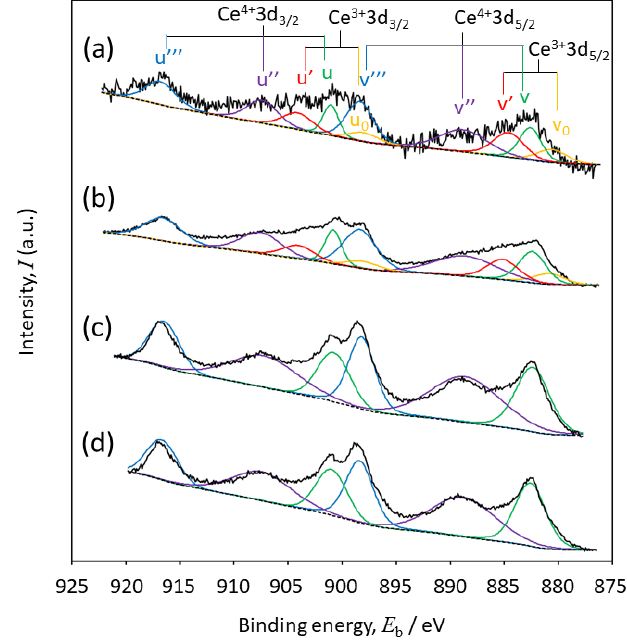
Figure 9. Ce3dspectraof( a )as-synthesizedCeO 2 , ( b )CeO 2 afterheatingat600 ◦ Cfor2h, ( c )as-synthesized Figure 9. Ce3d spectra of ( a ) as-synthesized CeO 2 , ( b ) CeO 2 after heating at 600 °C for 2 h, ( c ) as- PdCe4, and ( d ) PdCe4 after heating at 900 ◦ C for 2 synthesized PdCe4, and ( d ) PdCe4 after heating at 900 °C for 2 h.